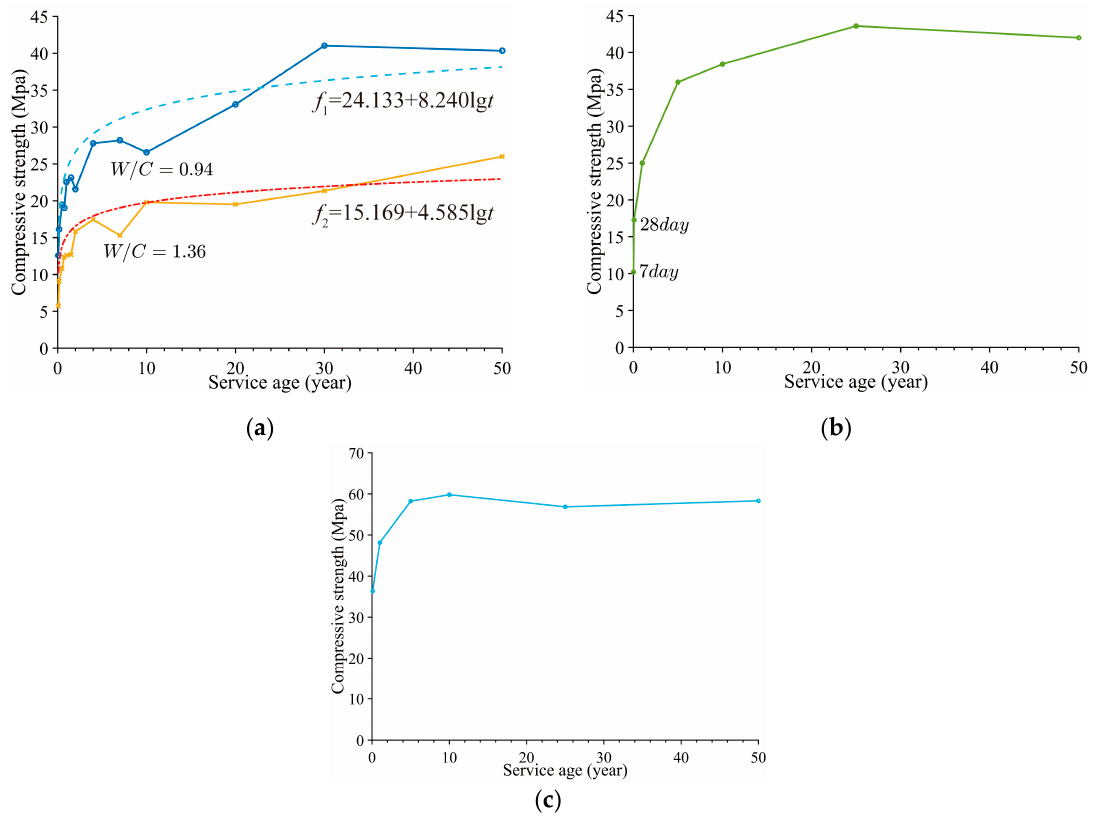
Figure 1. Relationship between service age and compressive strength of concrete specimens: ( a ) the concrete specimens of the 1910 series; ( b ) the concrete specimens of the 1923 series; ( c ) the concrete specimens of the 1937 series. (Based on the references [50–52]).